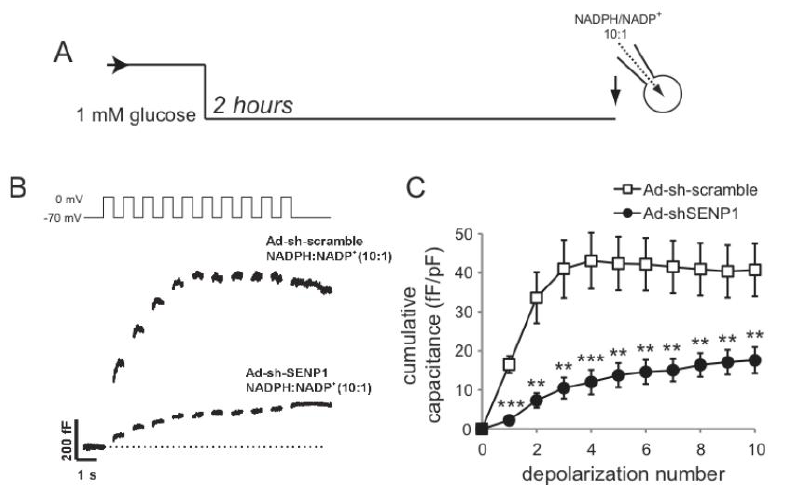
Figure 4. SENP1 is required for NADPH-dependent amplification of exocytosis. ( A ) Mouse β-cells were maintained at a non-stimulatory glucose concentration (1 mM) for 2 hours prior to intracellular dialysis of NADPH/NADP + at a molar ratio 10:1 and whole-cell patch-clamp measurement of exocytosis; ( B , C ) Representative traces ( B ) of exocytotic responses and averaged data ( C ) in control cells (Ad-sh-scramble) or following SENP1 knockdown (Ad-sh-SENP1). ** p < 0.01 and *** p < 0.001 compared with Ad-sh-scramble.